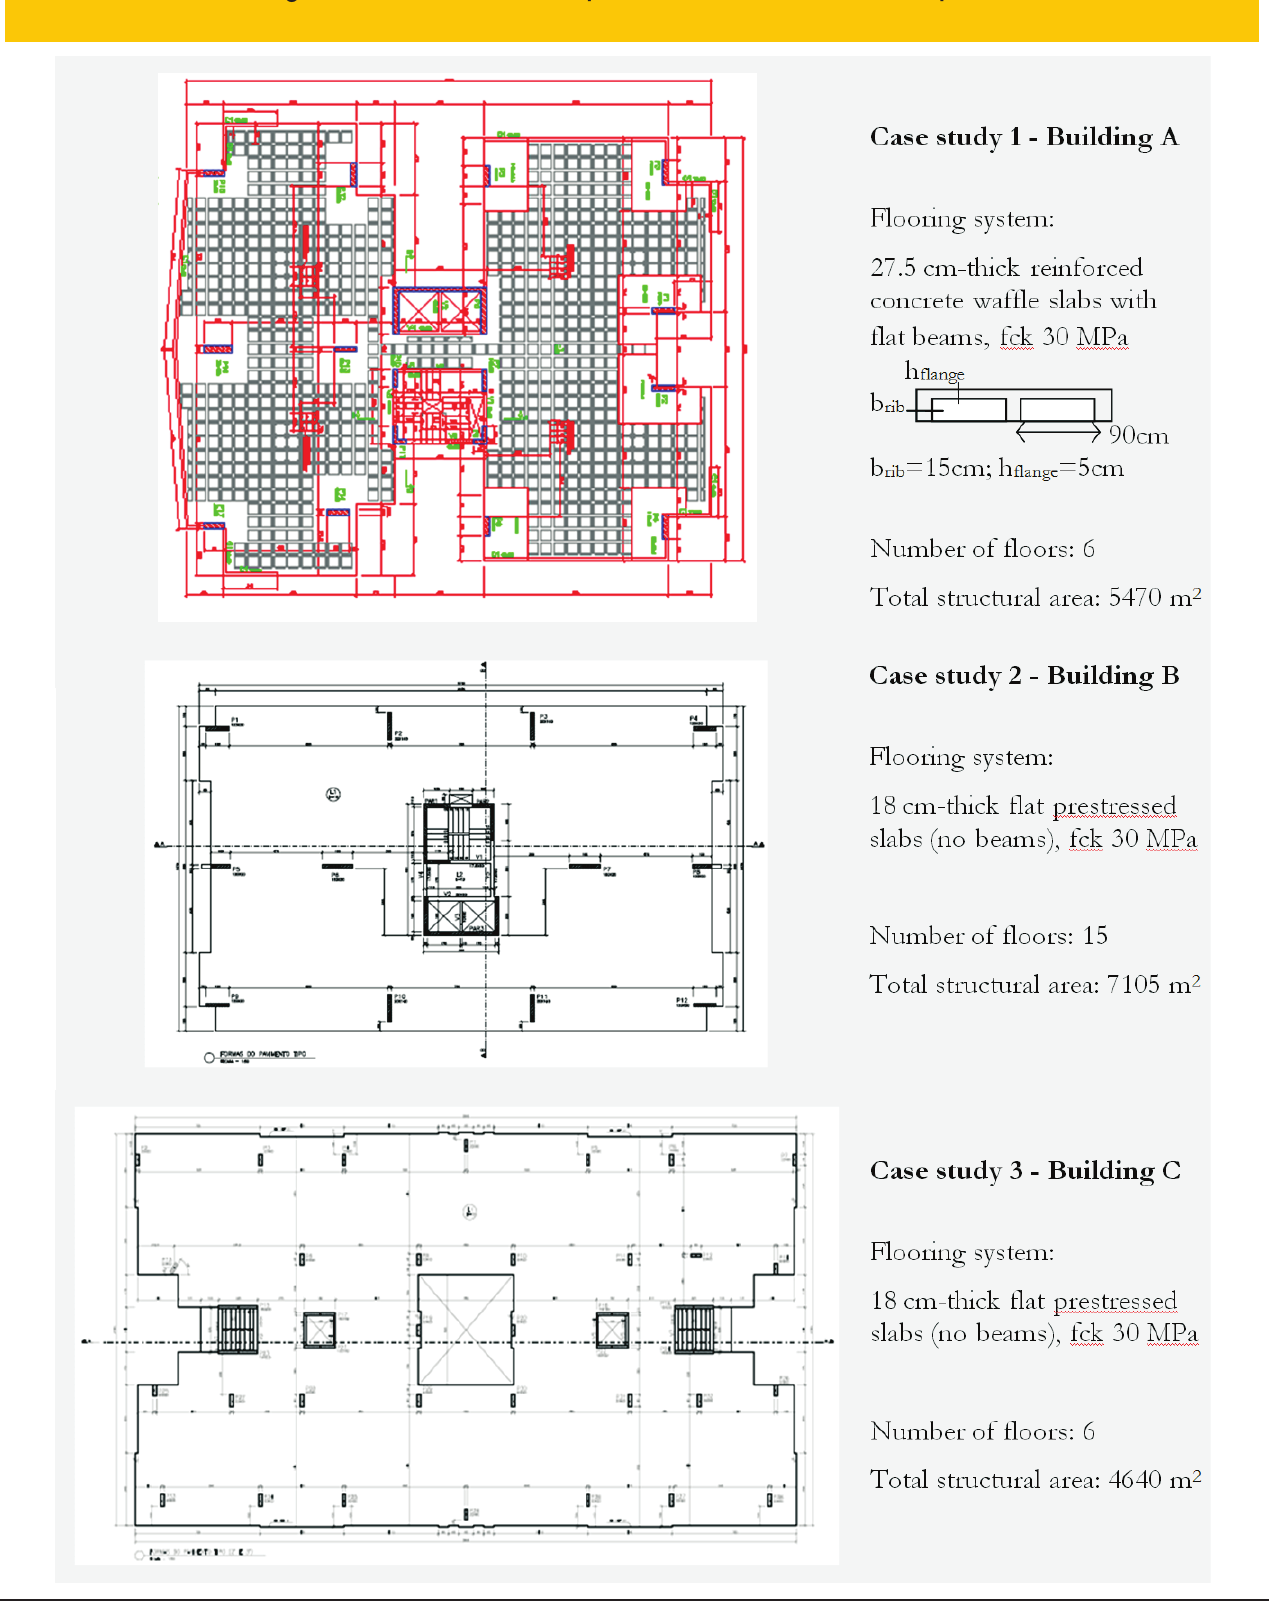
Figure 1 – Case studies' floor plan and structural frame